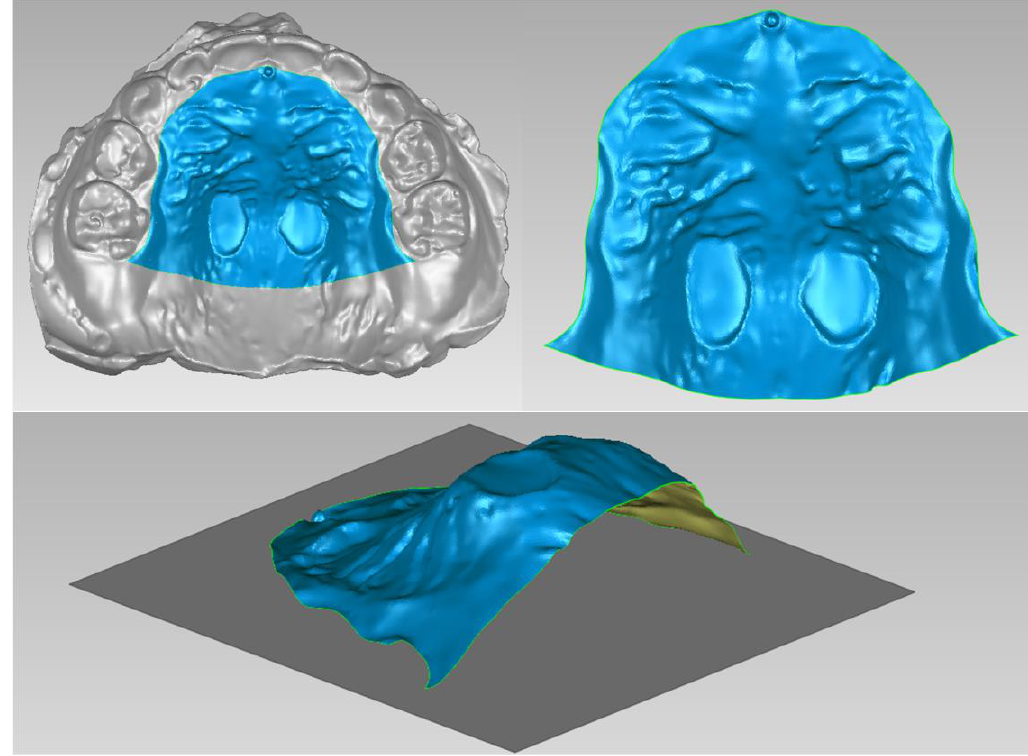
Figure 7. Digital cast measurement of the final cast. One operator assessed the reproducibility of the results by calculating intraclass correlation coefficients (ICC) for two repeated measurements within 2-week intervals. The ICC value was 0.985, with a 95% confidence limit (CI) of 0.991, which was calculated from the values of 0.847 and 0.998 (Figure 8).